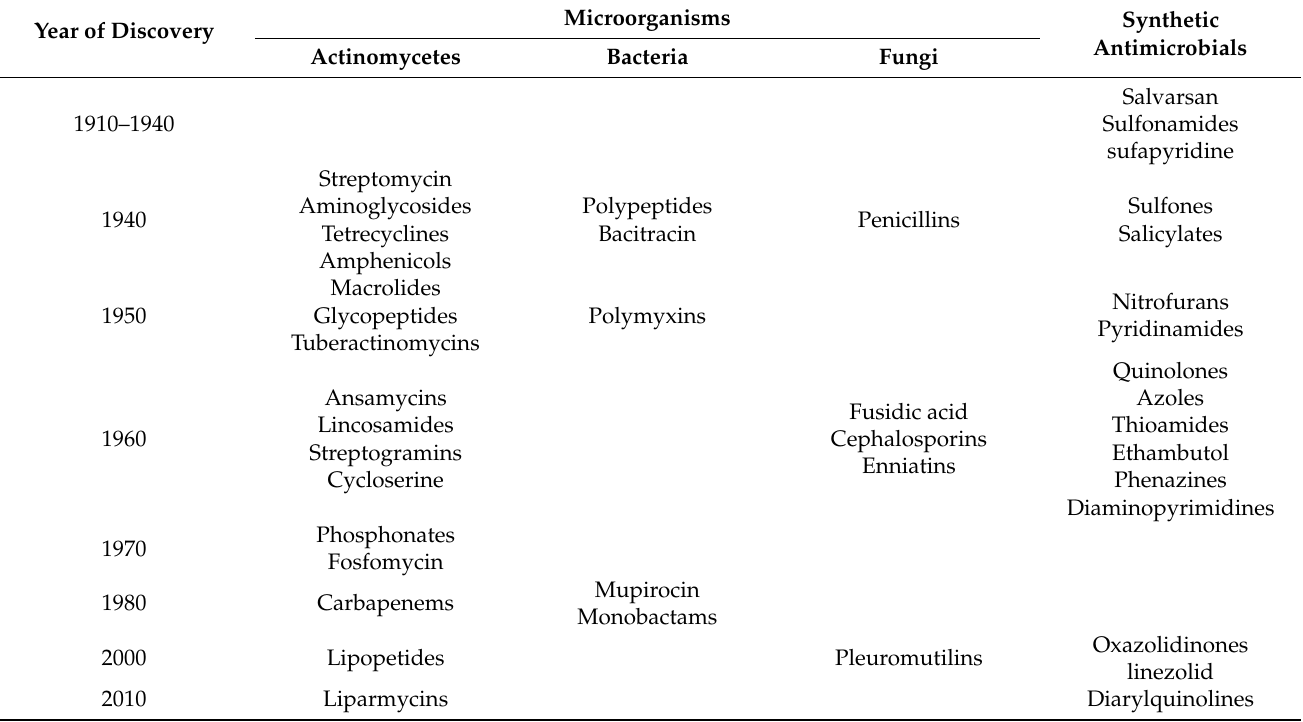
Table 1. Natural and Synthetic antimicrobials from 1910–2010